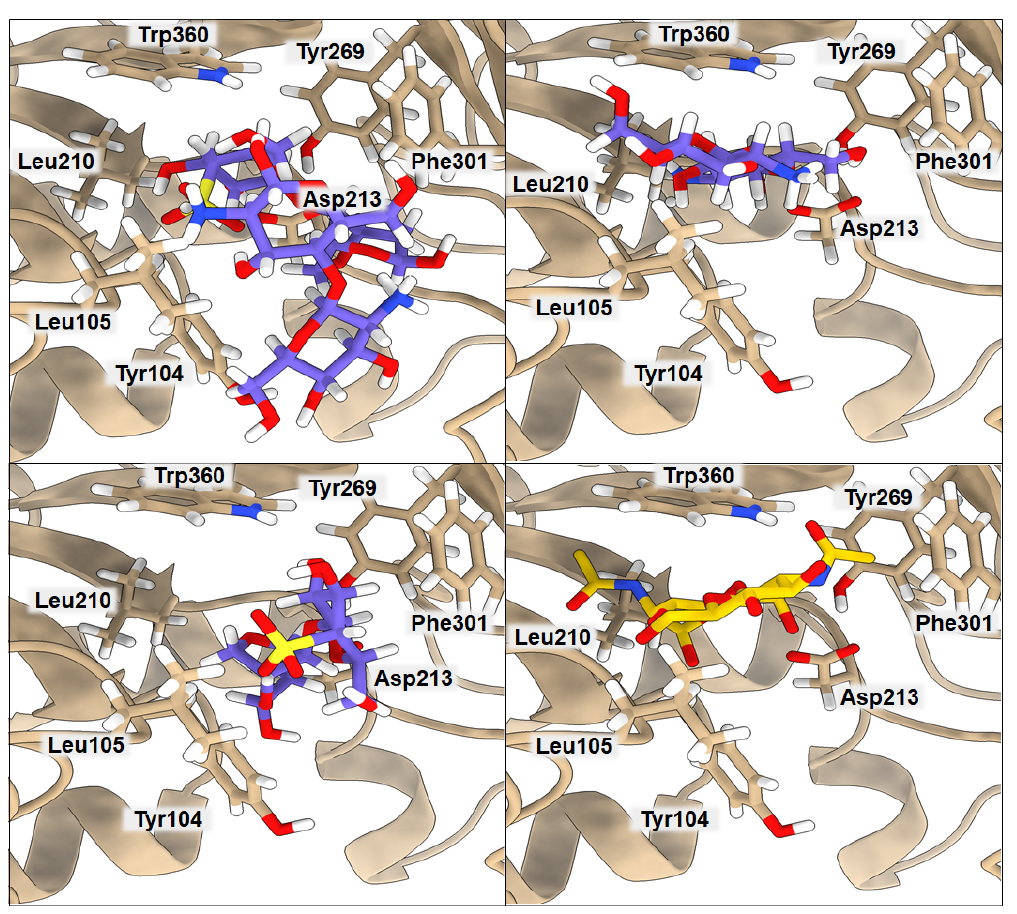
Table 4. Binding affinity (BA) computed for HA/CHI, HA, and CHI bound to hHyal-1, and repre- sentation of key distances between hHyal-1 amino acids and ligands. Values are reported in kcal·mol −1 and Å for BA and distances, respectively. Hydrogen bonds are marked in bold.